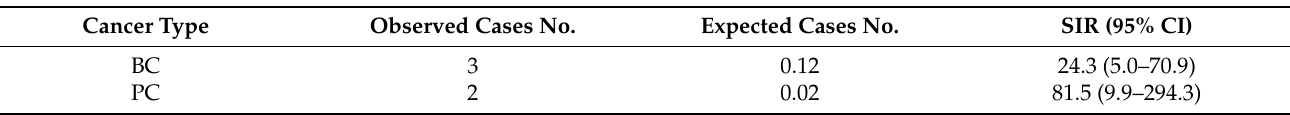
Table 2. Age and sex Standardized Incidence Ratio (SIR) of pancreatic and breast cancers in BRCA2- mutated